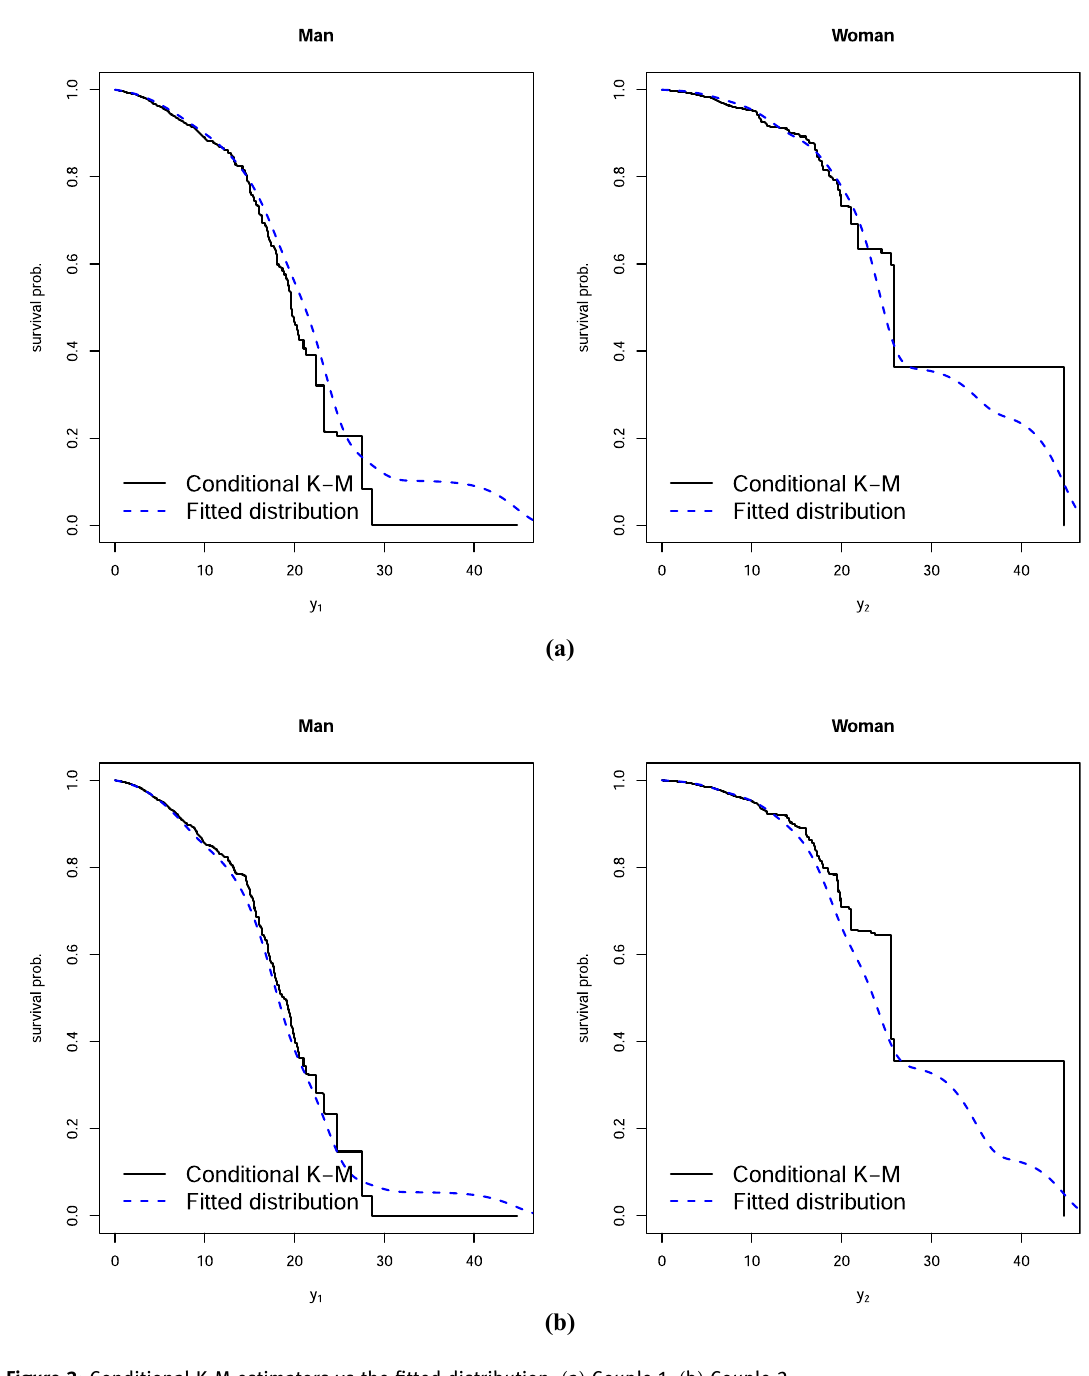
Figure 3: Conditional K - M estimators vs the fi tted distribution. ( a ) Couple 1. ( b ) Couple